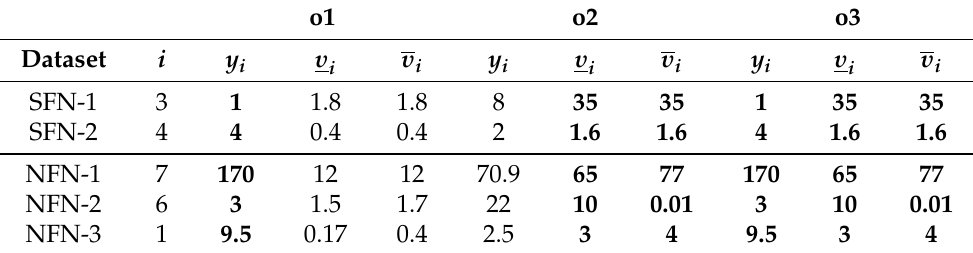
Table 2. Outliers of type o1 (columns 3–5), o2 (columns 6 - 8) and o3 (columns 9–11) in datasets (column 1) are identified by their serial numbers i (column 2). Original values of means m ˜ spreads α ˜ and left spreads β ˜ of the observations ˜ Y are in normal text and the changed values are Y Y in